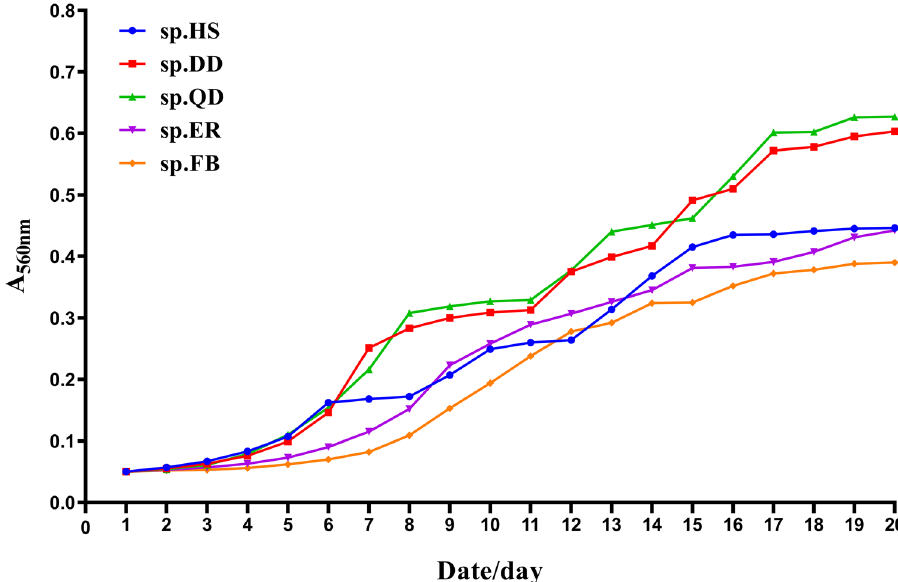
Figure 4. Growth curves of the Arthrospira five species.